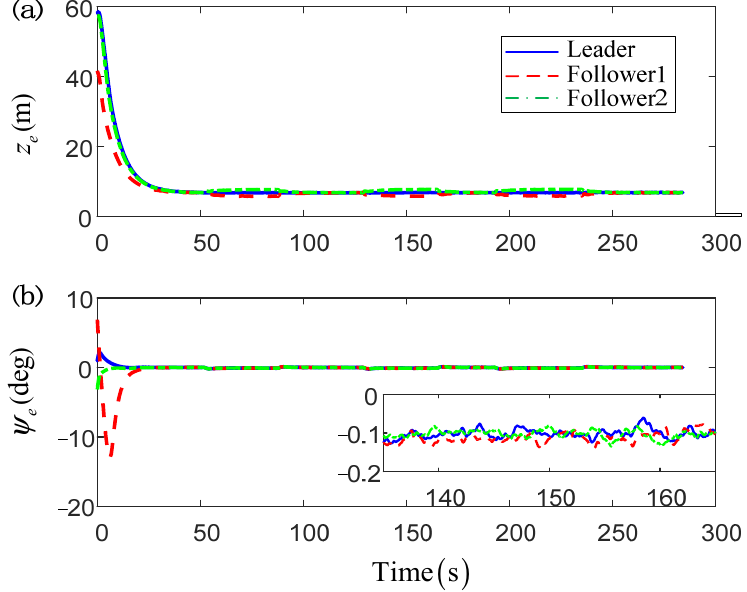
Figure 5. The position and heading angle errors for USVs: ( a ) error curves of position; ( b ) error curves of heading angle.